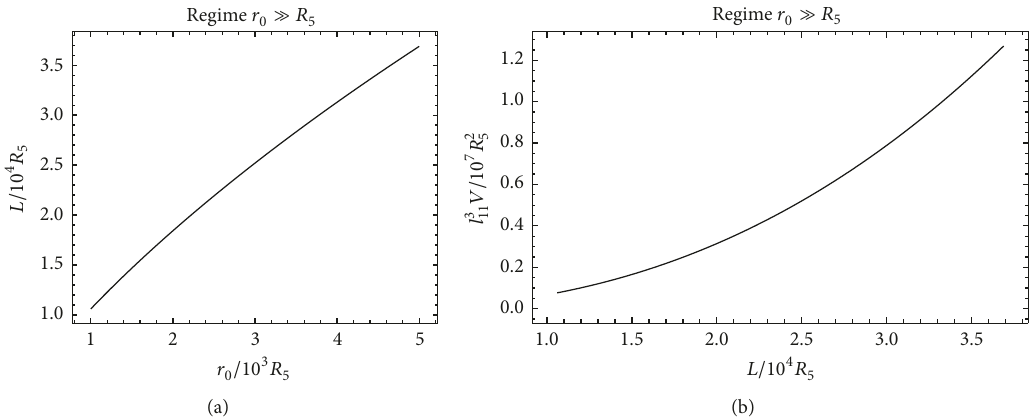
Figure 10: (a) Distance 𝐿/𝑅 5 between quarks in a M5 brane space versus 𝑟 0 /𝑅 5 . (b) Potential interaction 𝑙 3 11 𝑉/𝑅 2 5 between quarks in a M5 brane space versus the distance 𝐿/𝑅 5 . Here, in both panels 𝑟 1 /𝑅 5 = 10 5 and 𝑟 0 /𝑅 5 > 10 3 .